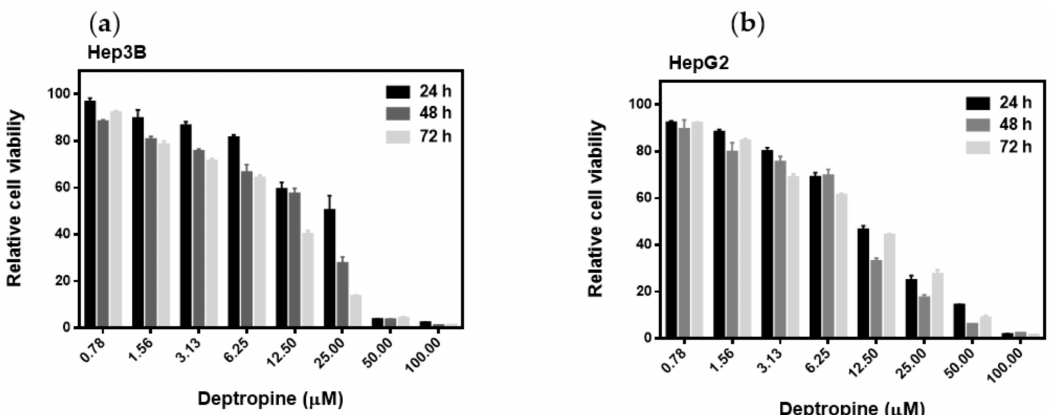
Figure 2. Dose- and time-dependent e ff ects of deptropine on the cell viability of human hepatoma cells. ( a ) Hep3B and ( b ) HepG2 cells were treated with di ff erent concentrations of deptropine for 24, 48, or 72 h, and cell viability was determined by an 3-(4,5-Dimethylthiazol-2-yl)-2,5-Diphenyltetrazolium Bromide (MTT) assay. Data are presented as the mean ± standard error of three independent